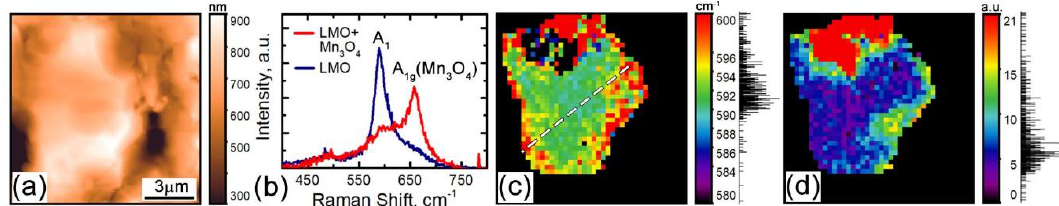
Figure 1. Complimentary atomic force microscopy (AFM) and micro-Raman spectroscopy of an active ionic particle: ( a ) AFM topography image of the area mapped with the micro-Raman spectroscopy. ( b ) Averaged Raman spectra in the Li 0.6 Mn 2 O 4 and Mn 3 O 4 phases from the blue and red regions, respectively, of the map in panel ( d ). ( c ) Distribution of the A 1 Raman peak shift corresponding to the local lithiation state. ( d ) Distribution of the A 1g peak intensity reflecting aggregation of the Mn 3 O 4 phase. Signal histograms are displayed on the right from the color scalebars of the corresponding images. The dashed line in ( c ) indicates the line used to extract the profile of the Raman peak shift displayed in Figure 5a.